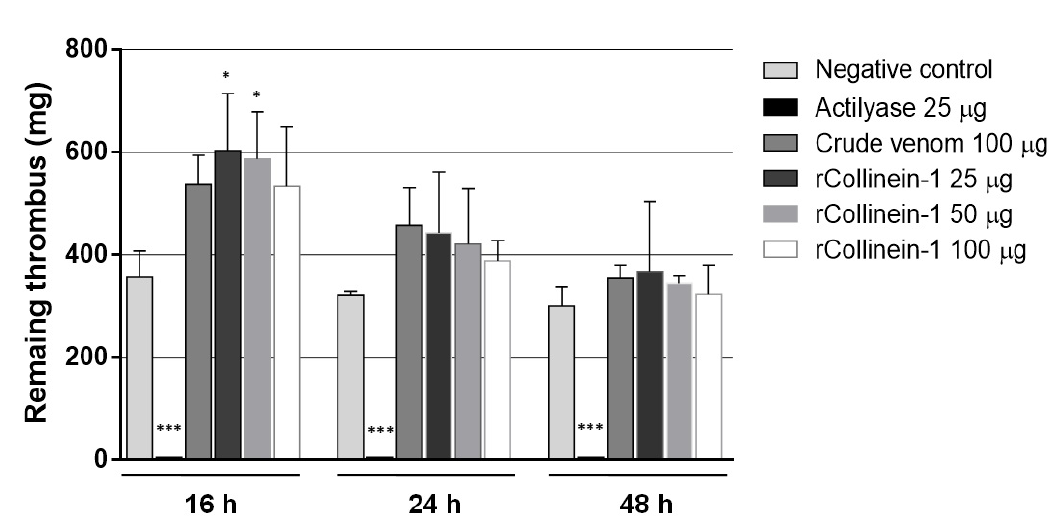
Figure 3. Thrombolytic activity of rCollinein-1. Thrombolytic activity was assessed on blood clots formed in vitro , as described by Toni [41]. For this, 500 μL of fresh blood (collected from healthy volunteers without anticoagulant addition) was added to 24-well plates, followed by incubation for 1 h at room temperature for clot formation. After this period, the clots were incubated for 16, 24 and 48 hours at 37 °C with different concentrations of the enzyme (25, 50, 100 μg in 500 μL of saline). Samples containing only saline and 25 μg Actilyase were used as negative and positive controls, respectively. Crude venom was also tested at a concentration of 100 μg/μL. After incubation, thrombolytic activity was estimated based on the weight of the remaining wet clot. Data were expressed as means ±S.E.M. from three separated experiments. * p < 0.05 and *** p < 0.001 compared to the negative